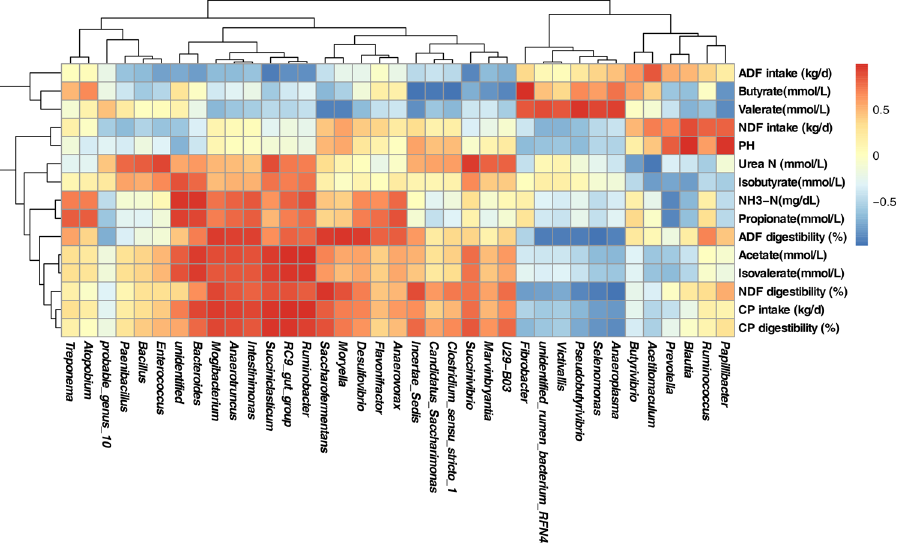
Figure 5. Correlation between physiological / production parameter and genus abundance. The top and left hierarchical cluster based on the corresponding correlation matrix between physiological / production parameters and genus abundance. The similar clusters were found with complete linkage method. Only the predominant bacterial genera (representing at least 1% of the bacterial community in at least one sample) are presented; Cells are coloured based on the Pearson correlation coefficient between physiological / production parameter and genus abundance. The red colour represents a positive correlation; the blue colour represents a negative